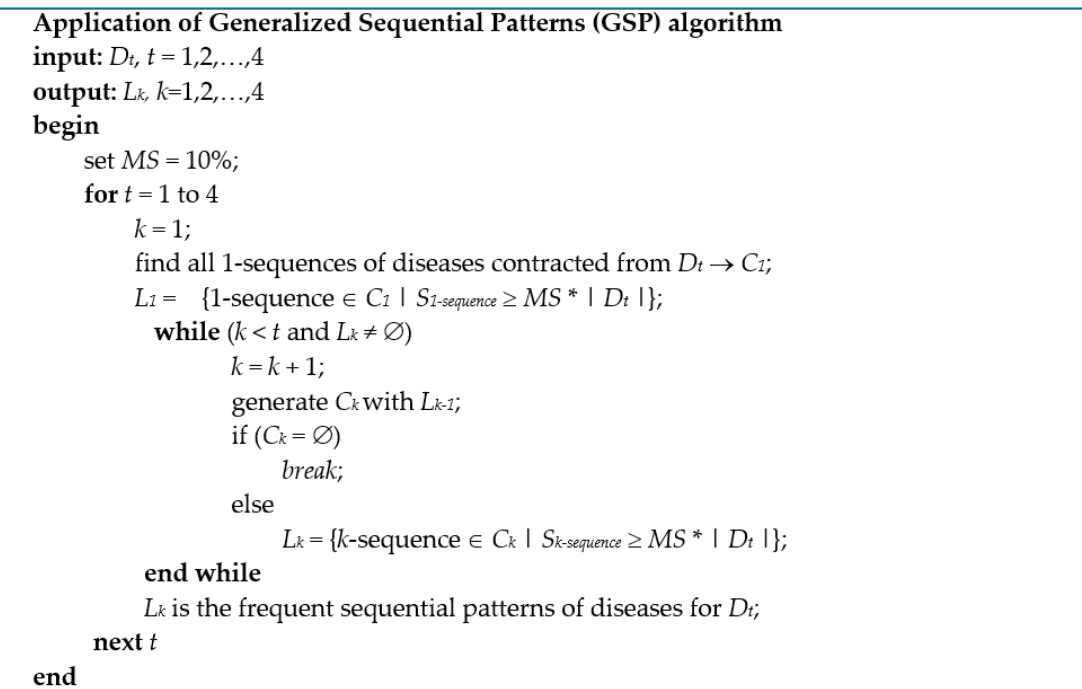
Figure 3. The pseudocode of the GSP algorithm to find the sequential patterns of diseases.